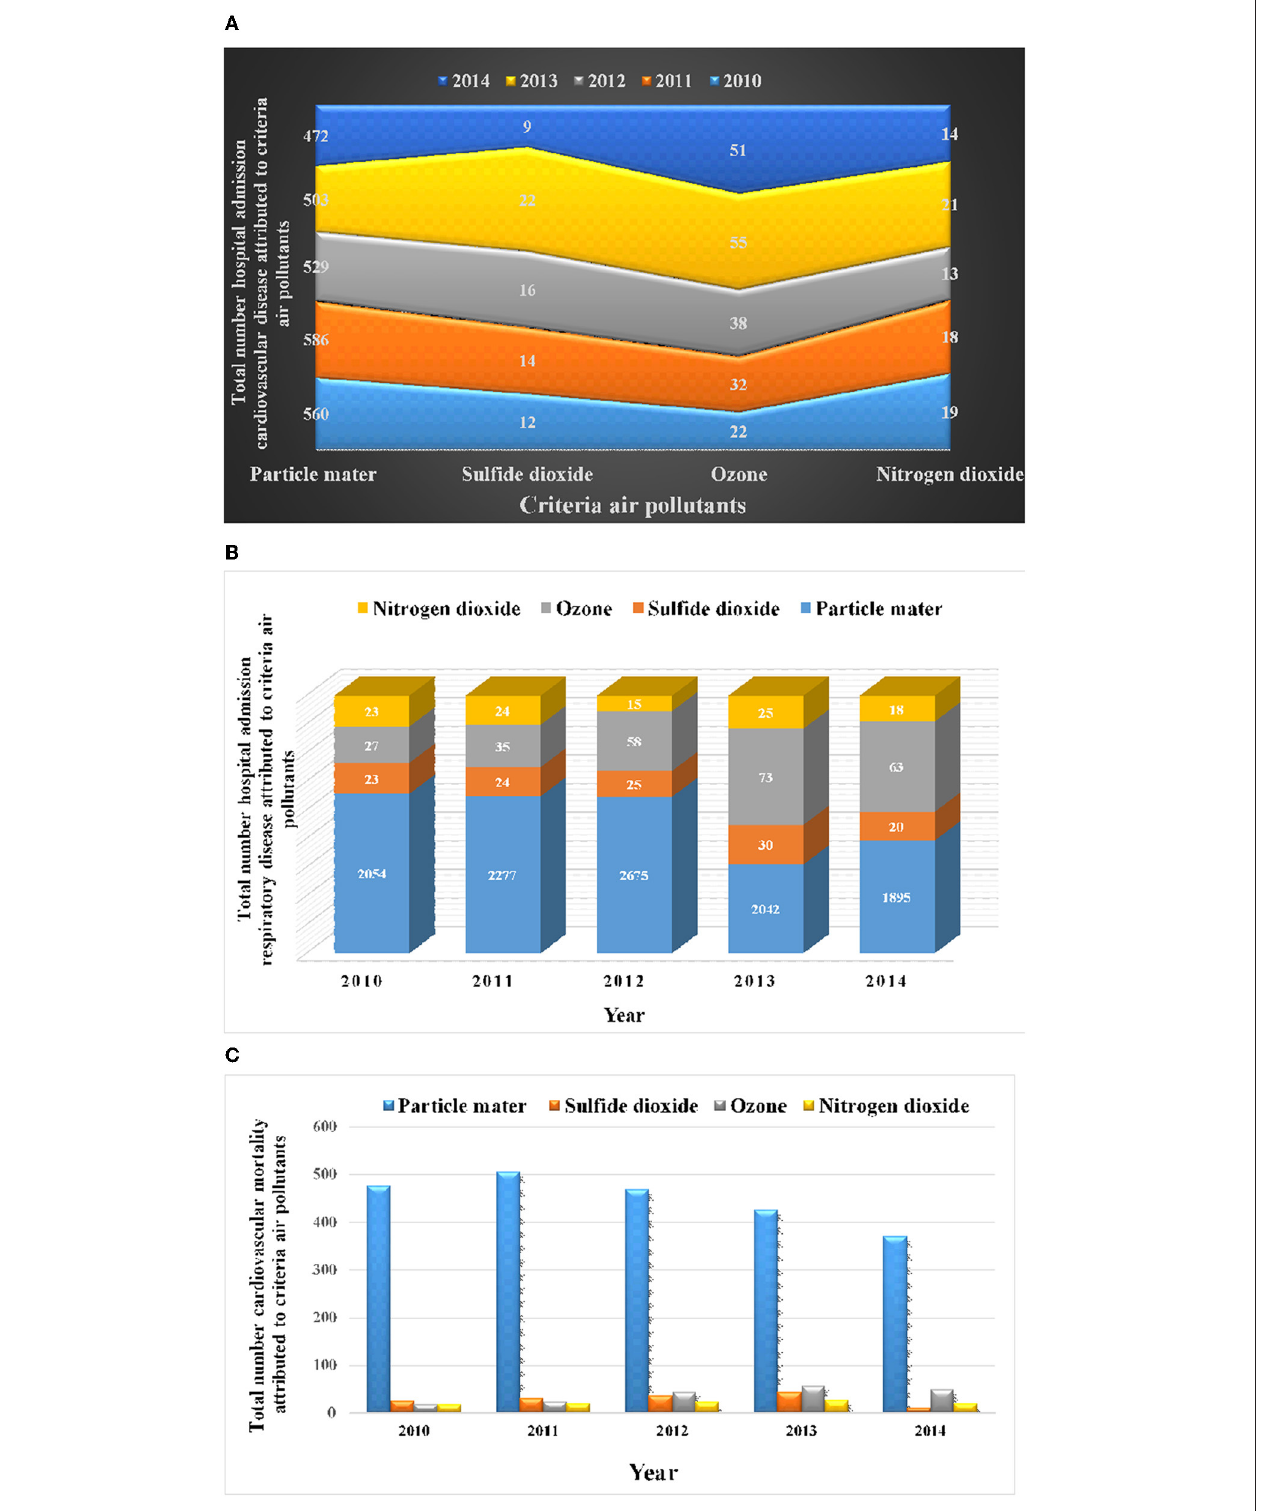
FIGURE 3 | Cumulative number of cardiovascular mortality, hospital admission respiratory disease, hospital admission cardiovascular disease related to criteria air pollutants. (A) Number of hospital admission cardiovascular disease. (B) Number of hospital admission respiratory disease. (C) Number of cardiovascular mortality.